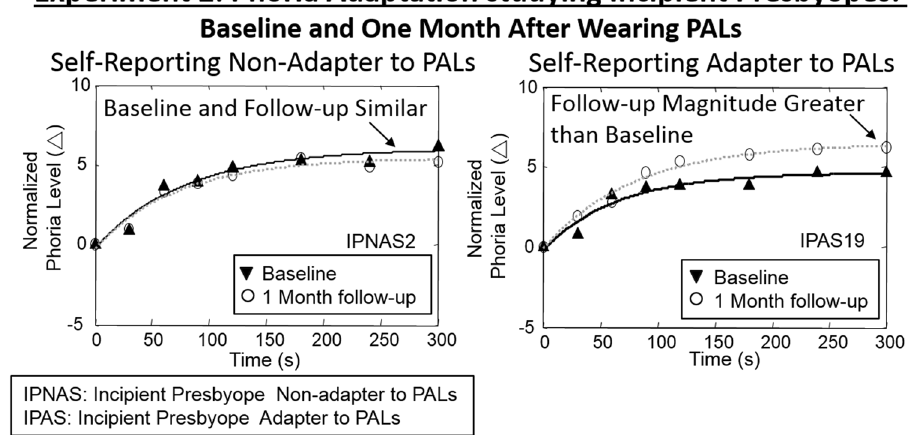
Figure 5. Normalized phoria measurements with exponential fit line before wearing PALs (black triangle, black line) and after one month of wearing PALs (white circle, gray line) during 5 minutes of 8.44° binocular fixation of a subject who did not adapt to PALs (IPNAS upper plots) and a subject who adapted to PALs (IPAS lower plots). Positive values mean an esophoric change in the subject’s phoria level and negative values means an exophoric change in the subject’s phoria